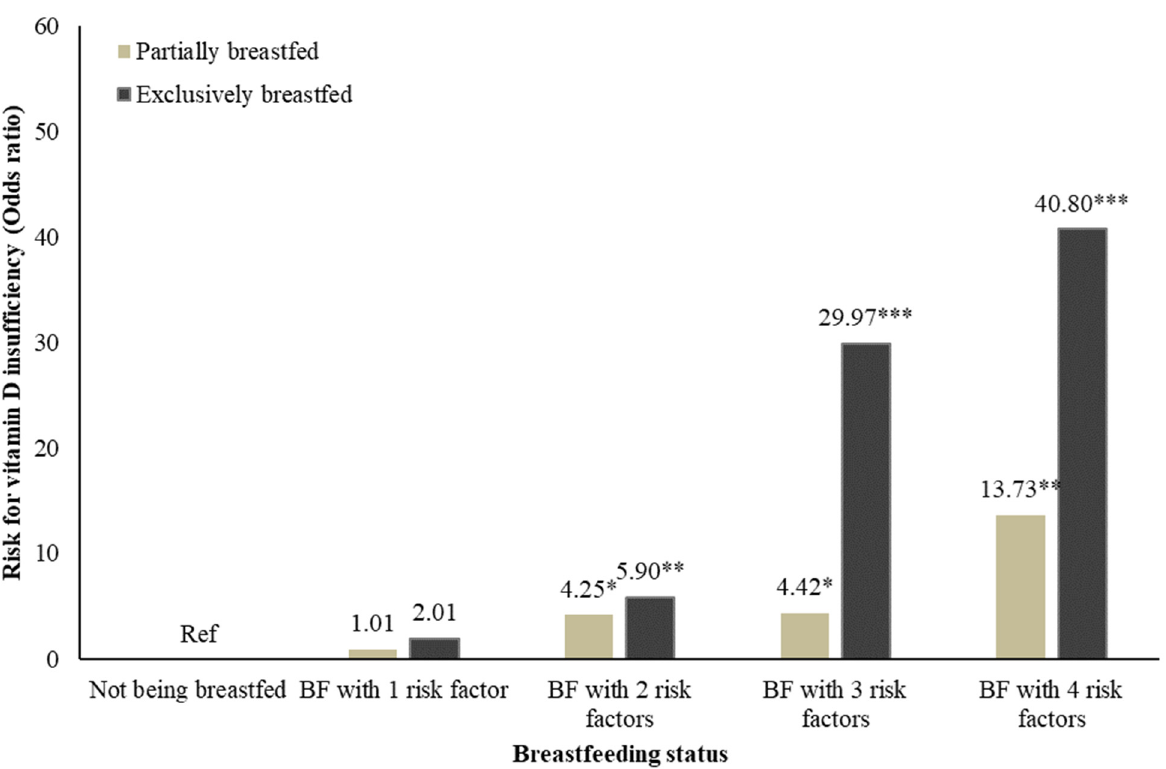
Figure 1. Cumulative risk model on vitamin D insufficiency or deficiency risk among breastfed infants. Note: * p < 0.05, ** p < 0.01, *** p < 0.001, BF: Breastfed, EBF: Exclusively breastfed.